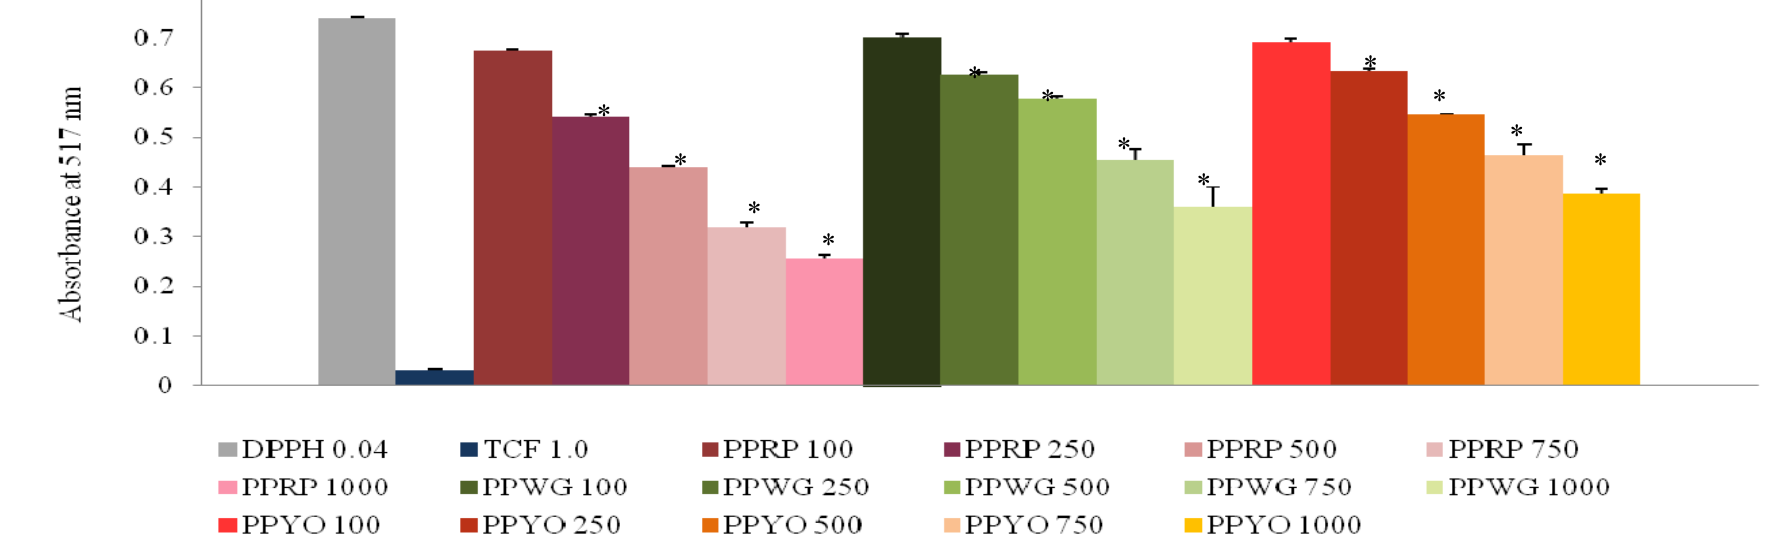
Figure 1 . Total antioxidant activity of α -tocopherol (TCF) and three varieties of prickly pear fruit—red-purple (PPRP), white-green (PPWG), and yellow-orange (PPYO)—evaluated with the DPPH (1,1-diphenyl-2-picrylhydrazyl radical) colorimetric assay. * Statistically significant difference with respect to the value of the DPPH group. ANOVA and Student t tests, p ≤